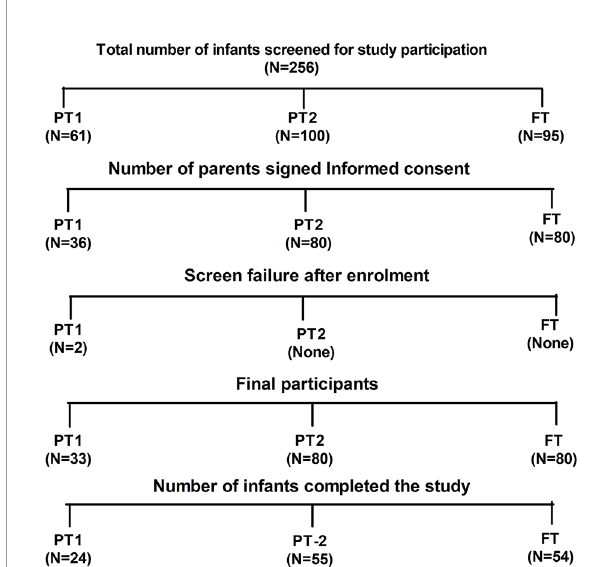
FIGURE 1 | Study participant disposition. Out of 256 screened infants, parents of 193 infants gave informed consent for participation in the study. Two preterm infants from PT1 group were failed two meet inclusion criteria hence excluded from the study. Finally, 133 infants were able to complete the